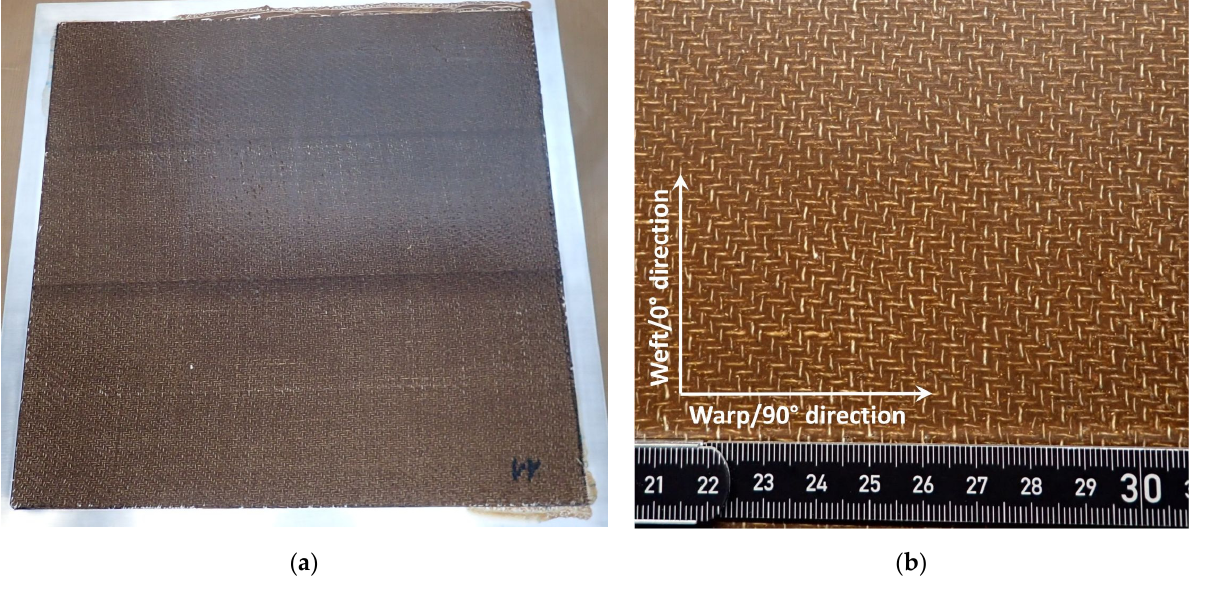
Figure 6. ( a ) Consolidated FL-LI composite plate with aluminium press frame; ( b ) warp (90°) and weft (0°) direction of composite plate.